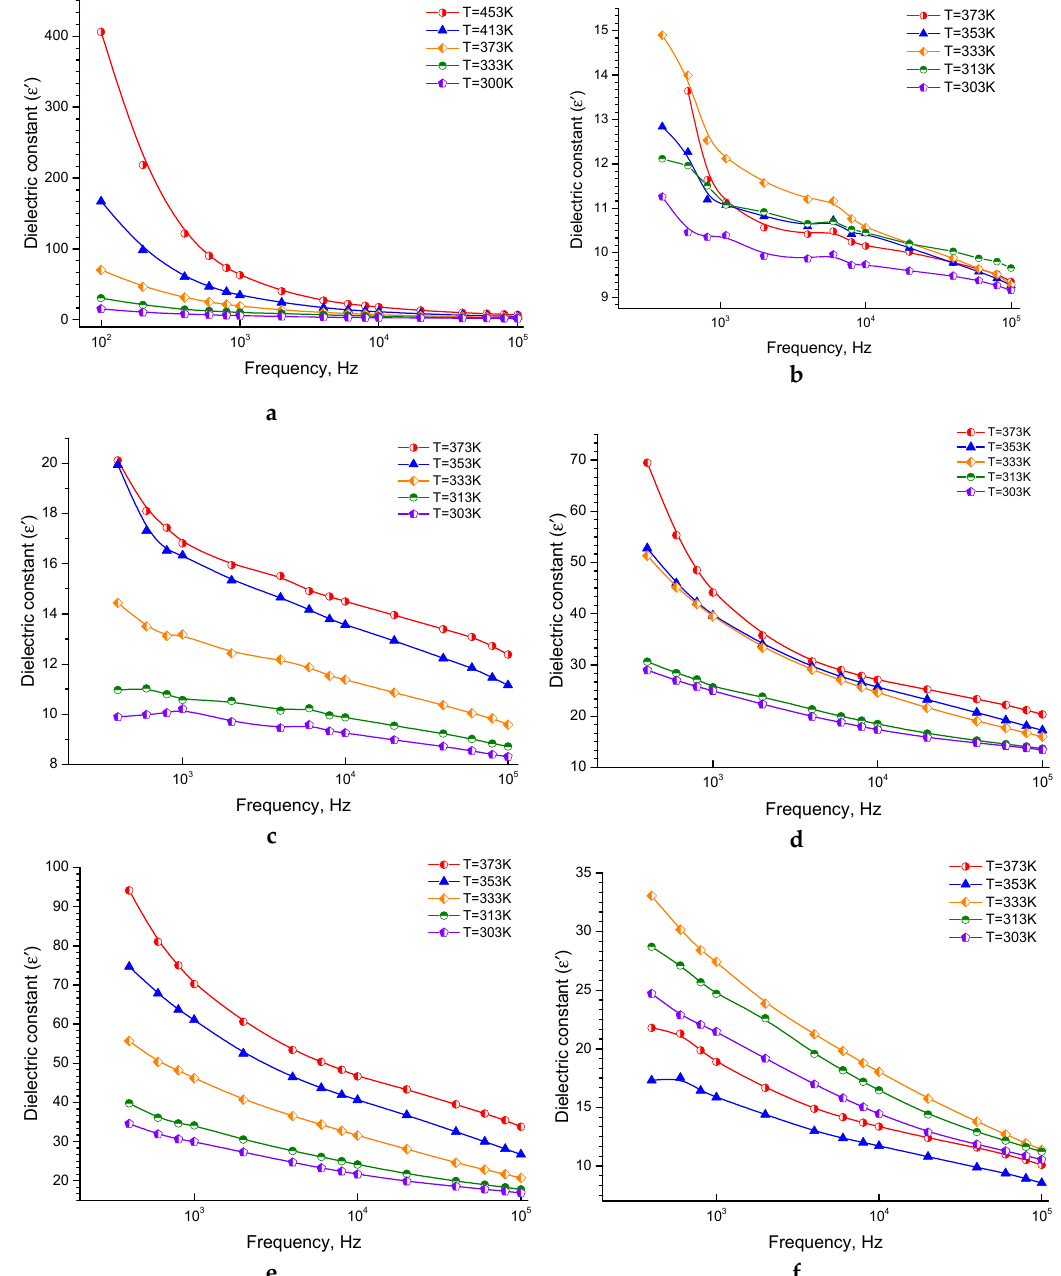
Figure 3. The ε ´ dielectric constant as a function of the frequency of ferrite sintered at 1473K ( a ), pure epoxy ( b ), 20% ferrite + 80% epoxy ( c ), 30% ferrite + 70% epoxy ( d ), 40% ferrite + 60% epoxy ( e ), 50% ferrite + 50% epoxy ( f ).